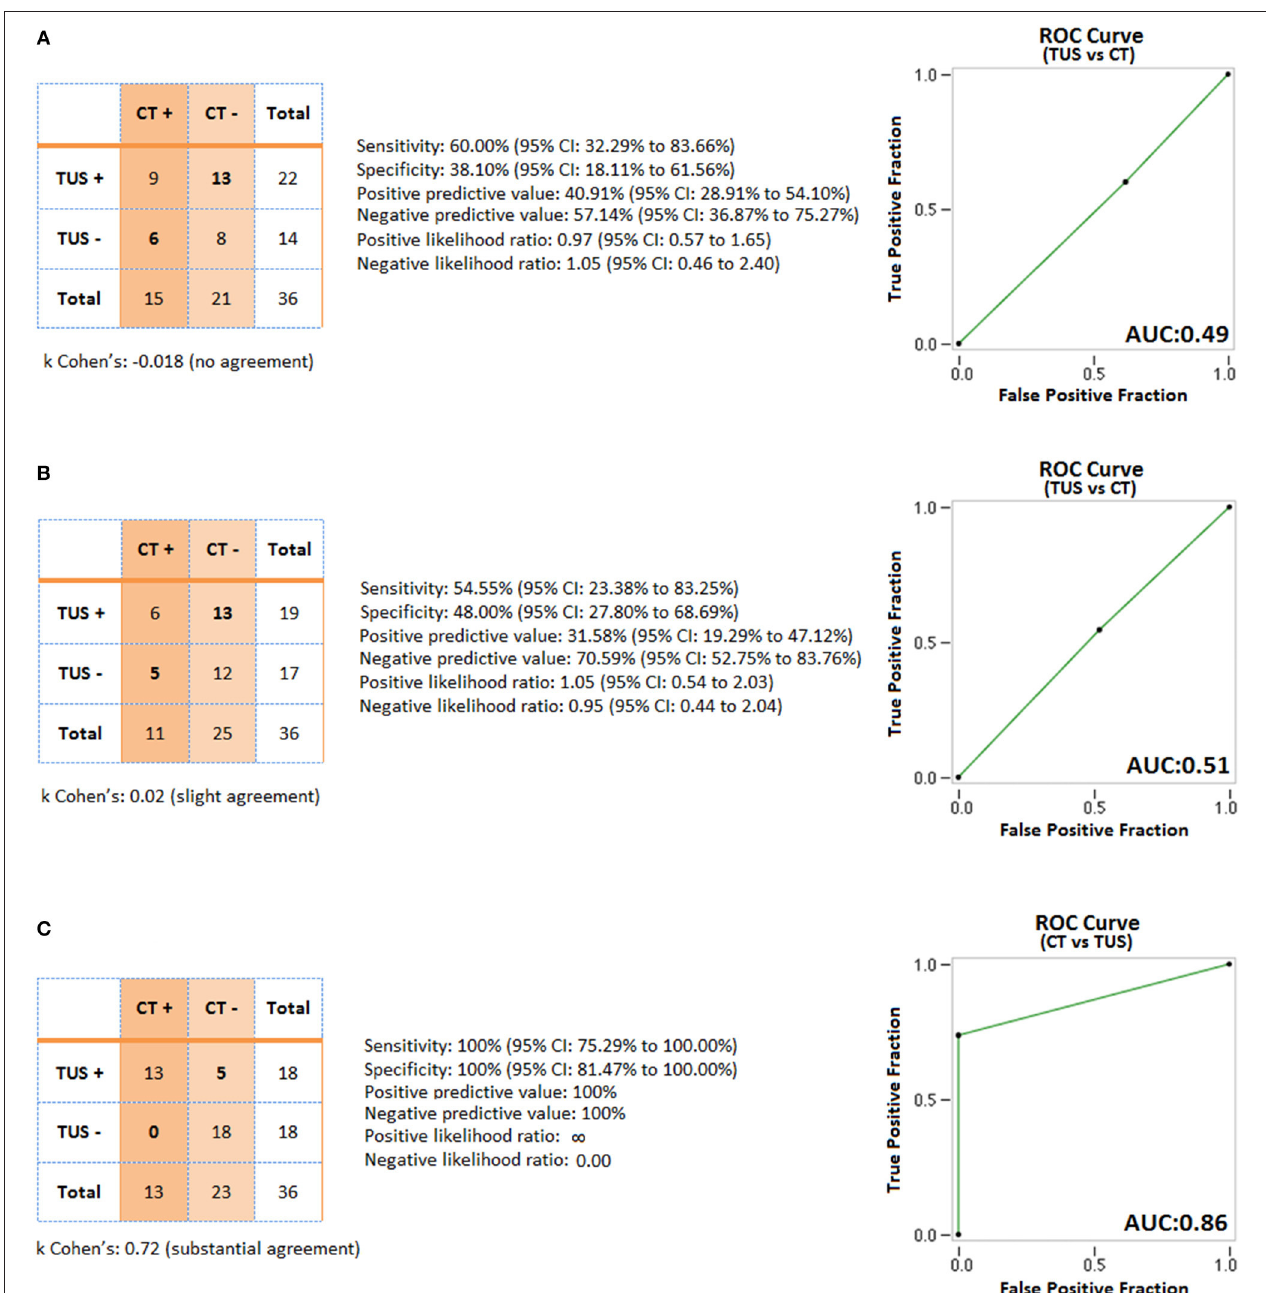
FIGURE 1 | 2 × 2 correlation matrixes of concordance and discordance between chest CT and TUS and ROC curves for the following signs of chronic pneumonia: (A) Air bronchogram; (B) Necrosis; (C) Pleural